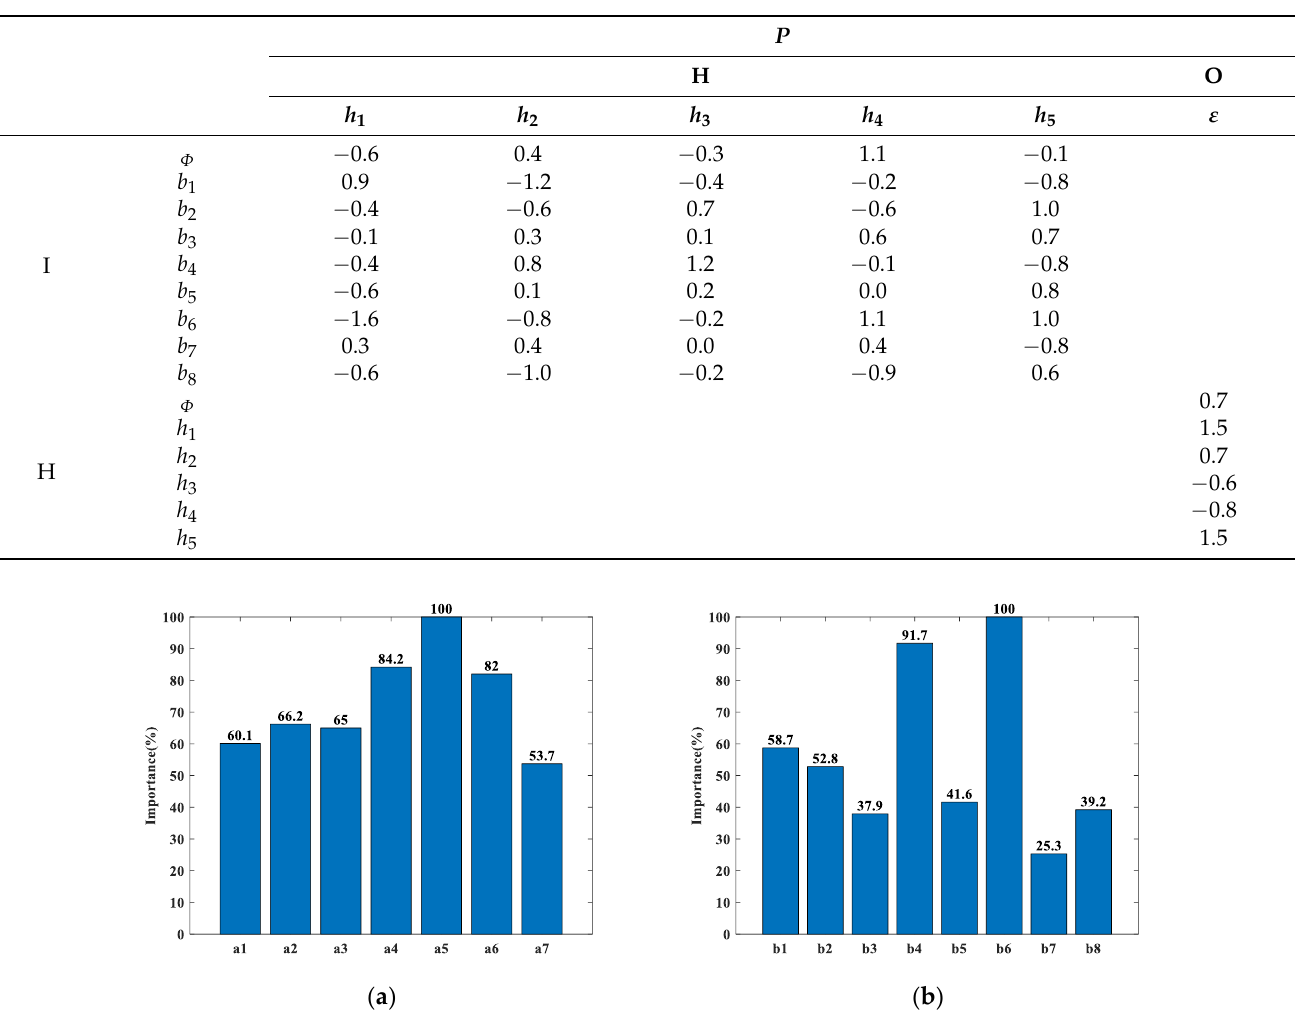
Figure 10. Importance of parameters. ( a ) PE debonding; ( b ) IC debonding.